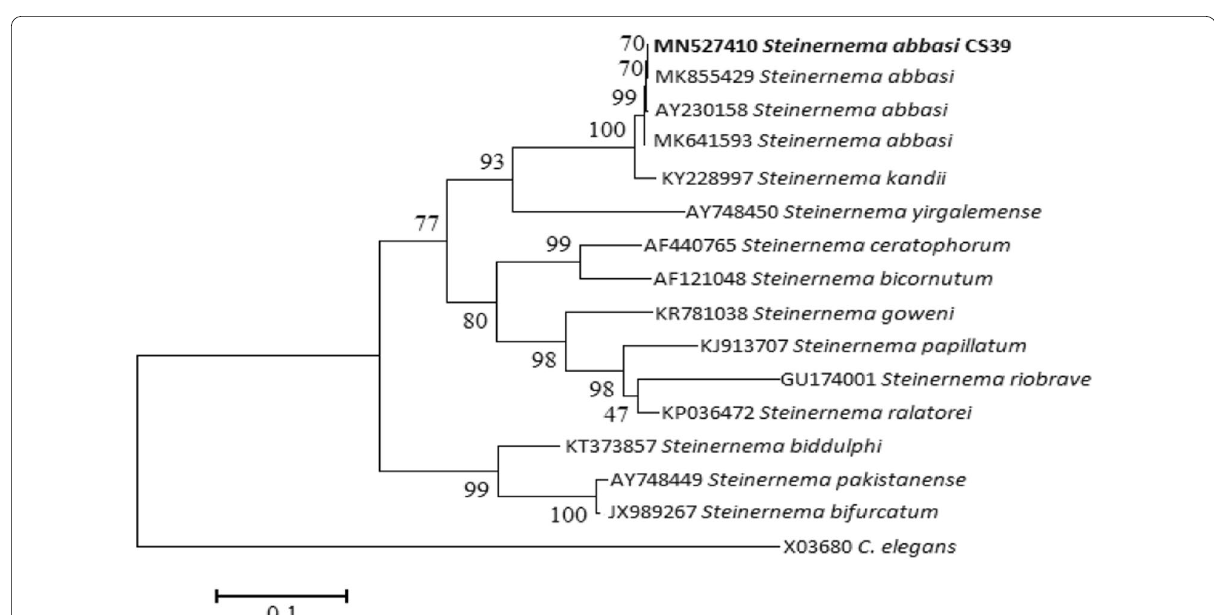
Fig. 1 Phylogenetic relationships in the “bicornutum” group of Steinernema based on analysis of ITS rDNA regions. Caenorhabditis elegans was used as outgroup taxa. The percentage of replicate trees in which the associated taxa clustered together in the bootstrap test (10,000 replicates) is shown next to the branches. Branch lengths indicate evolutionary distances and are expressed in the units of number of base differences per